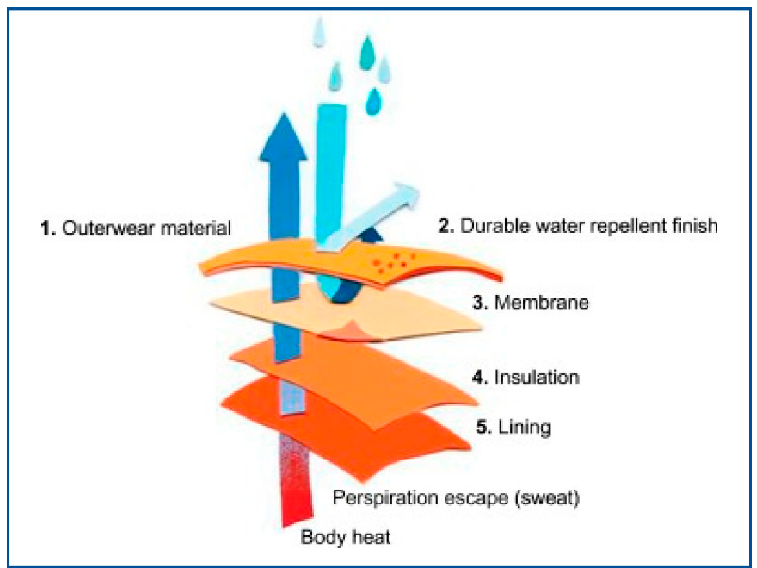
Figure 11. Examples of waterproof and breathable fabric textiles. The image was obtained under permission of [61]. permission of